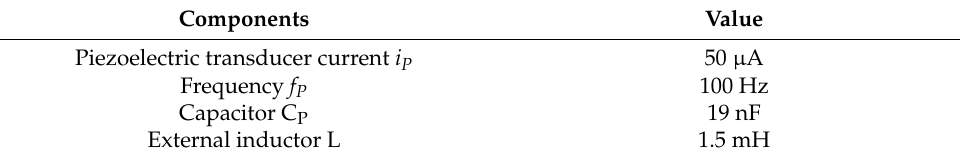
Table 1. Simulation